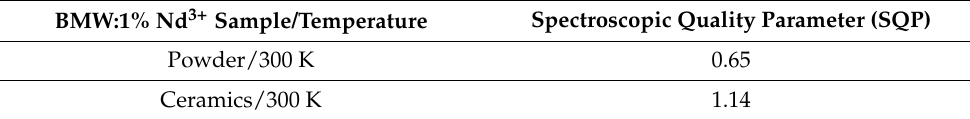
Table 2. The values of the spectroscopic quality parameter for BMW:1% Nd 3+